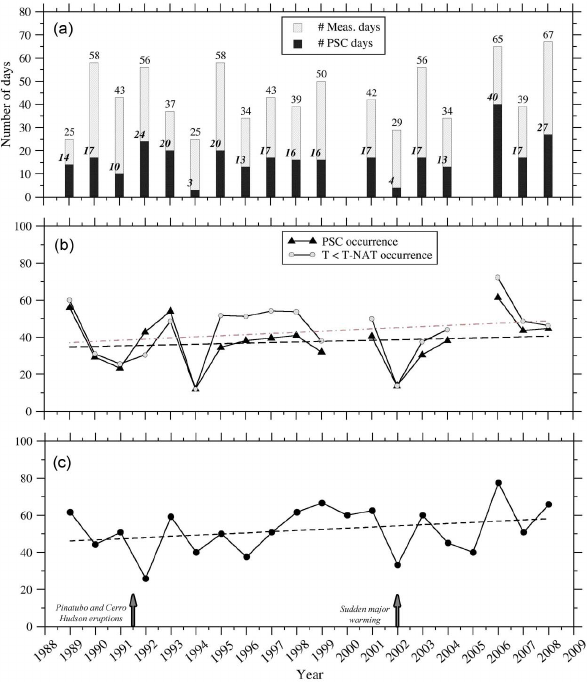
Fig. 9. Between 1989 and 2008 at Dumont d’Urville, (a) number of lidar measurements per year for the June to September period to- gether with the number of PSCs detections per year for the same pe- riod, (b) occurrences (%) of T <T NAT events (grey circles) and PSC (black triangle) over the number of lidar observations days, and (c) absolute occurrence (%) of T <T NAT days over the 120 days from 1 June to 30 September (independently of lidar measurements). Note that the PSC and T <T NAT occurrences are considered between the tropopause plus 1km and